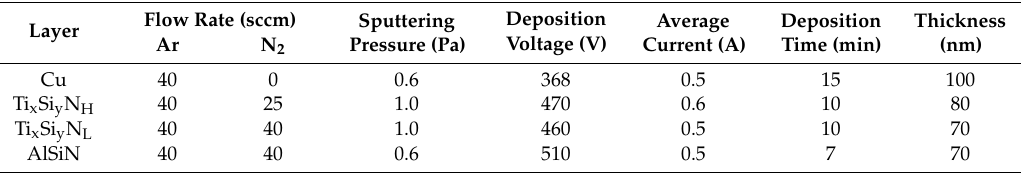
Deposition Average Deposition Thickness Voltage (V) Current (A) Time (min) Pressure (Pa)